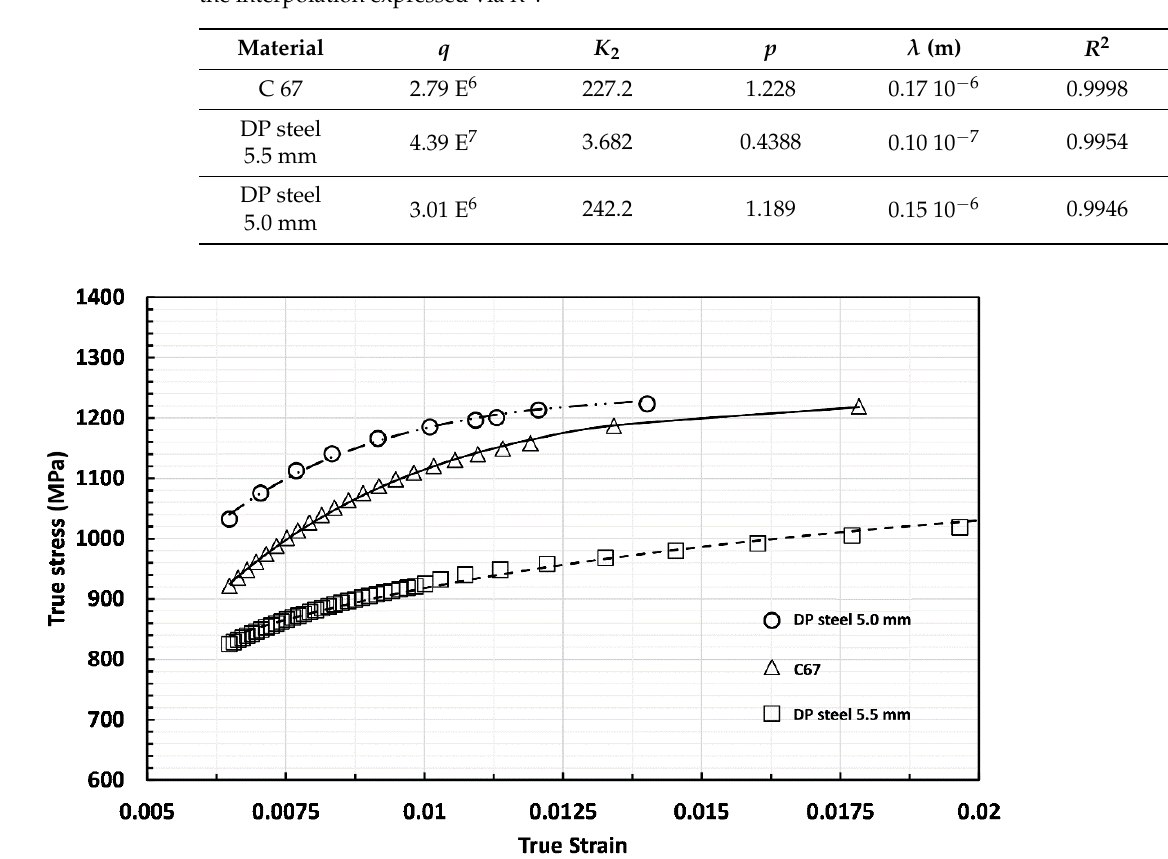
Figure 14. True stress–true strain curves for C67 and DP steel. Scattered symbols are experimental values, while lines are the calculated curves using the Voce equation.